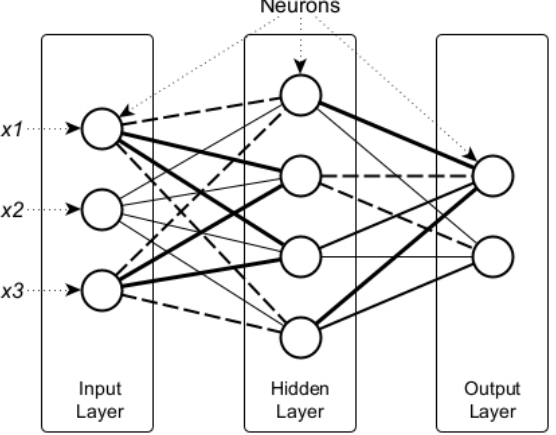
Figure 2. Artificial neural network architecture with multi-layered perceptron.